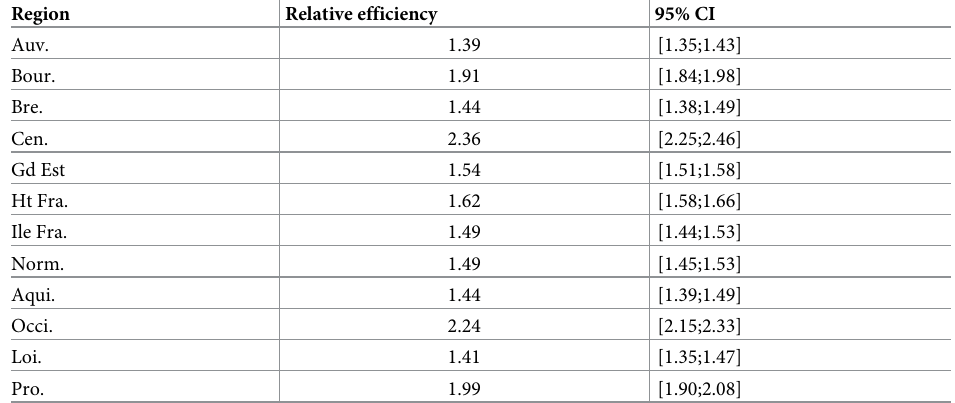
Table 15. Two-week ahead estimate—relative efficiency being bigger than one suggests increased predictive power of ARGONet compared to the AR(52) model. Region Relative efficiency 95% CI Auv.